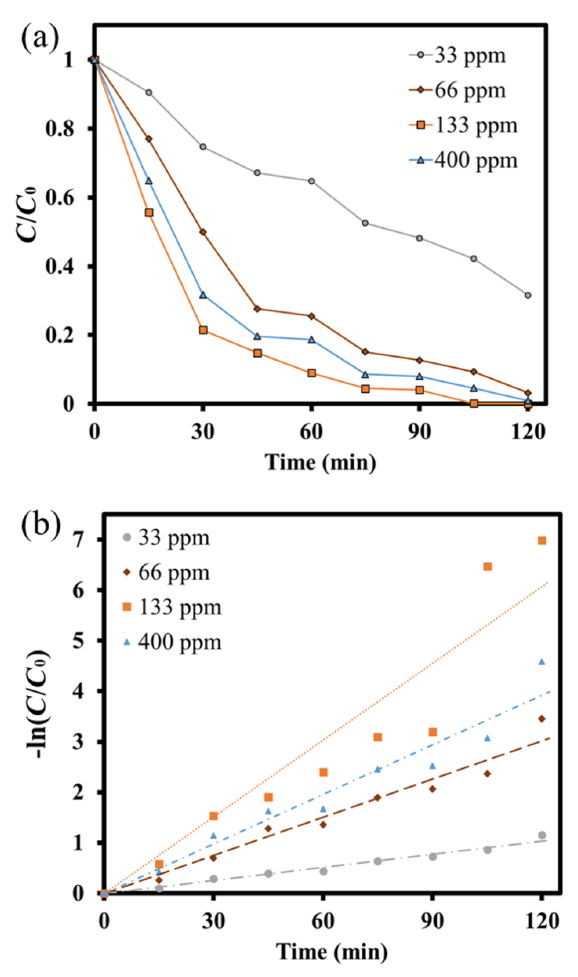
Figure 12: (a) The C / C 0 and (b) 1st order kinetic analysis of the photo- degradation using LaFe 0.7 Ni 0.3 O 3 operating at different H 2 O 2 addition.